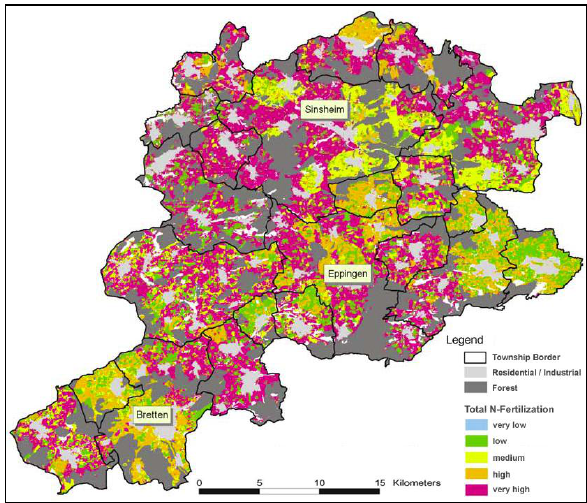
Figure 8. Total-N input for the “Kraichgau” (Rohierse, 2004)